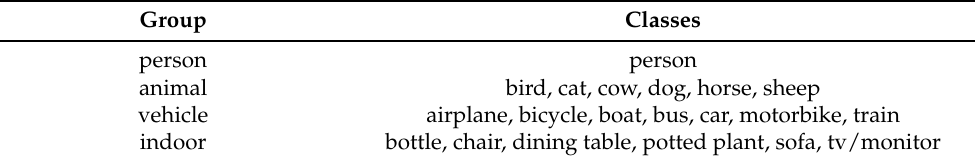
Table 1. Classes from the PASCAL VOC 2012